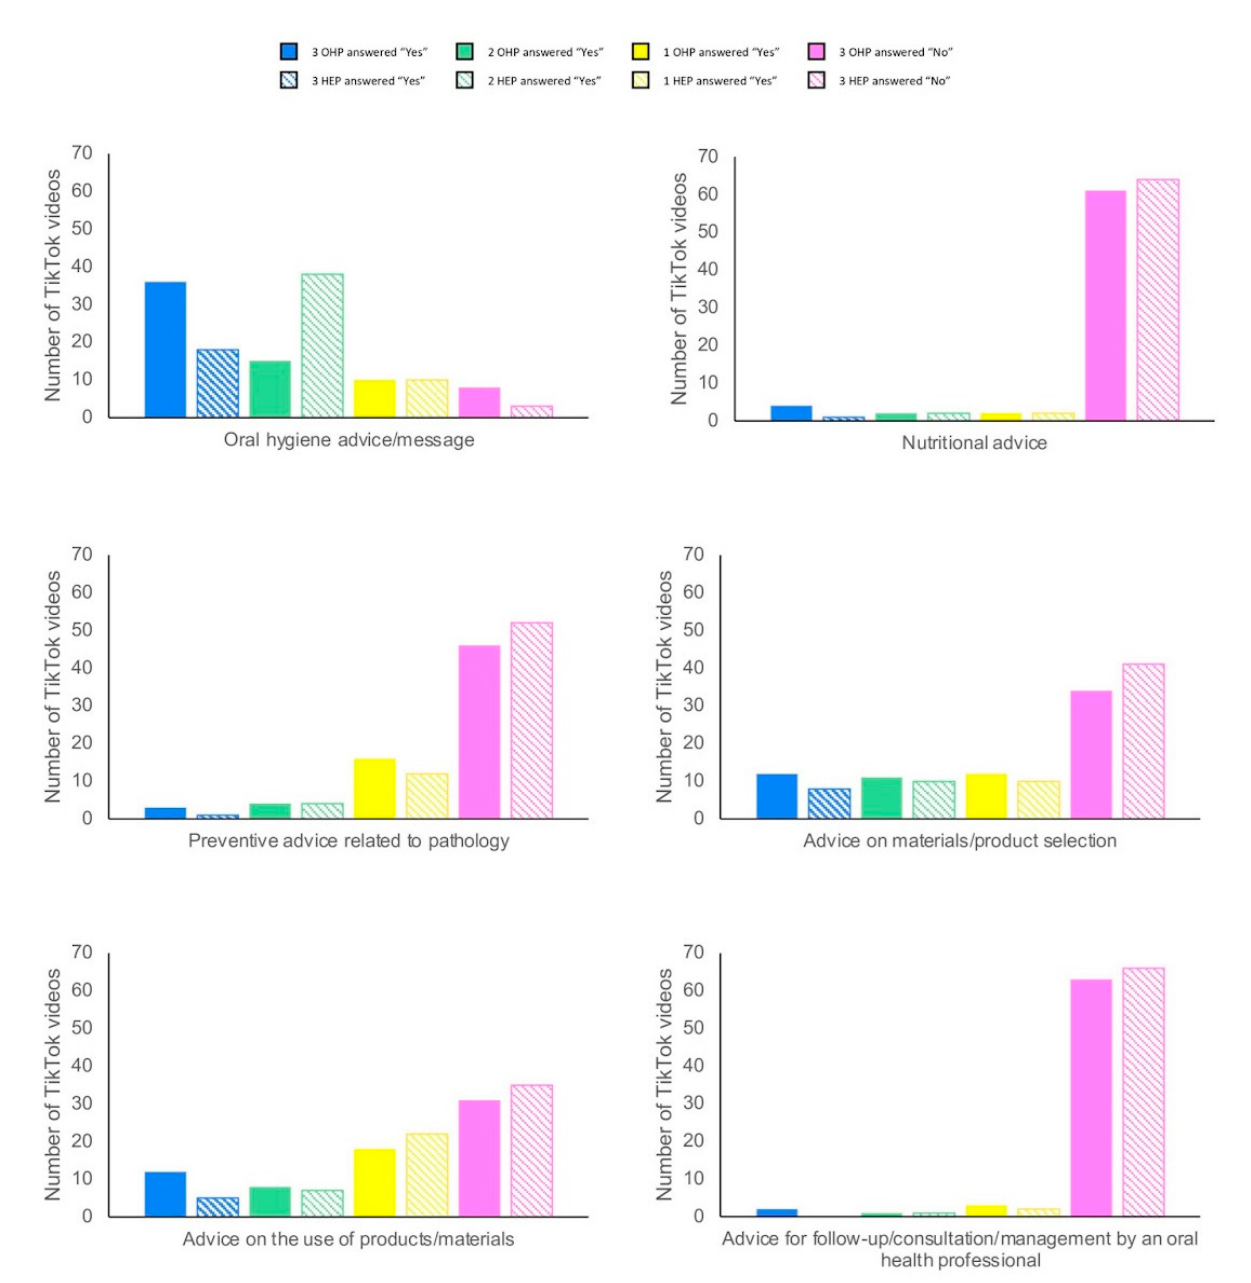
Figure 2. Targeted audience by TikTok videos corresponding to #oralhealtheducation.